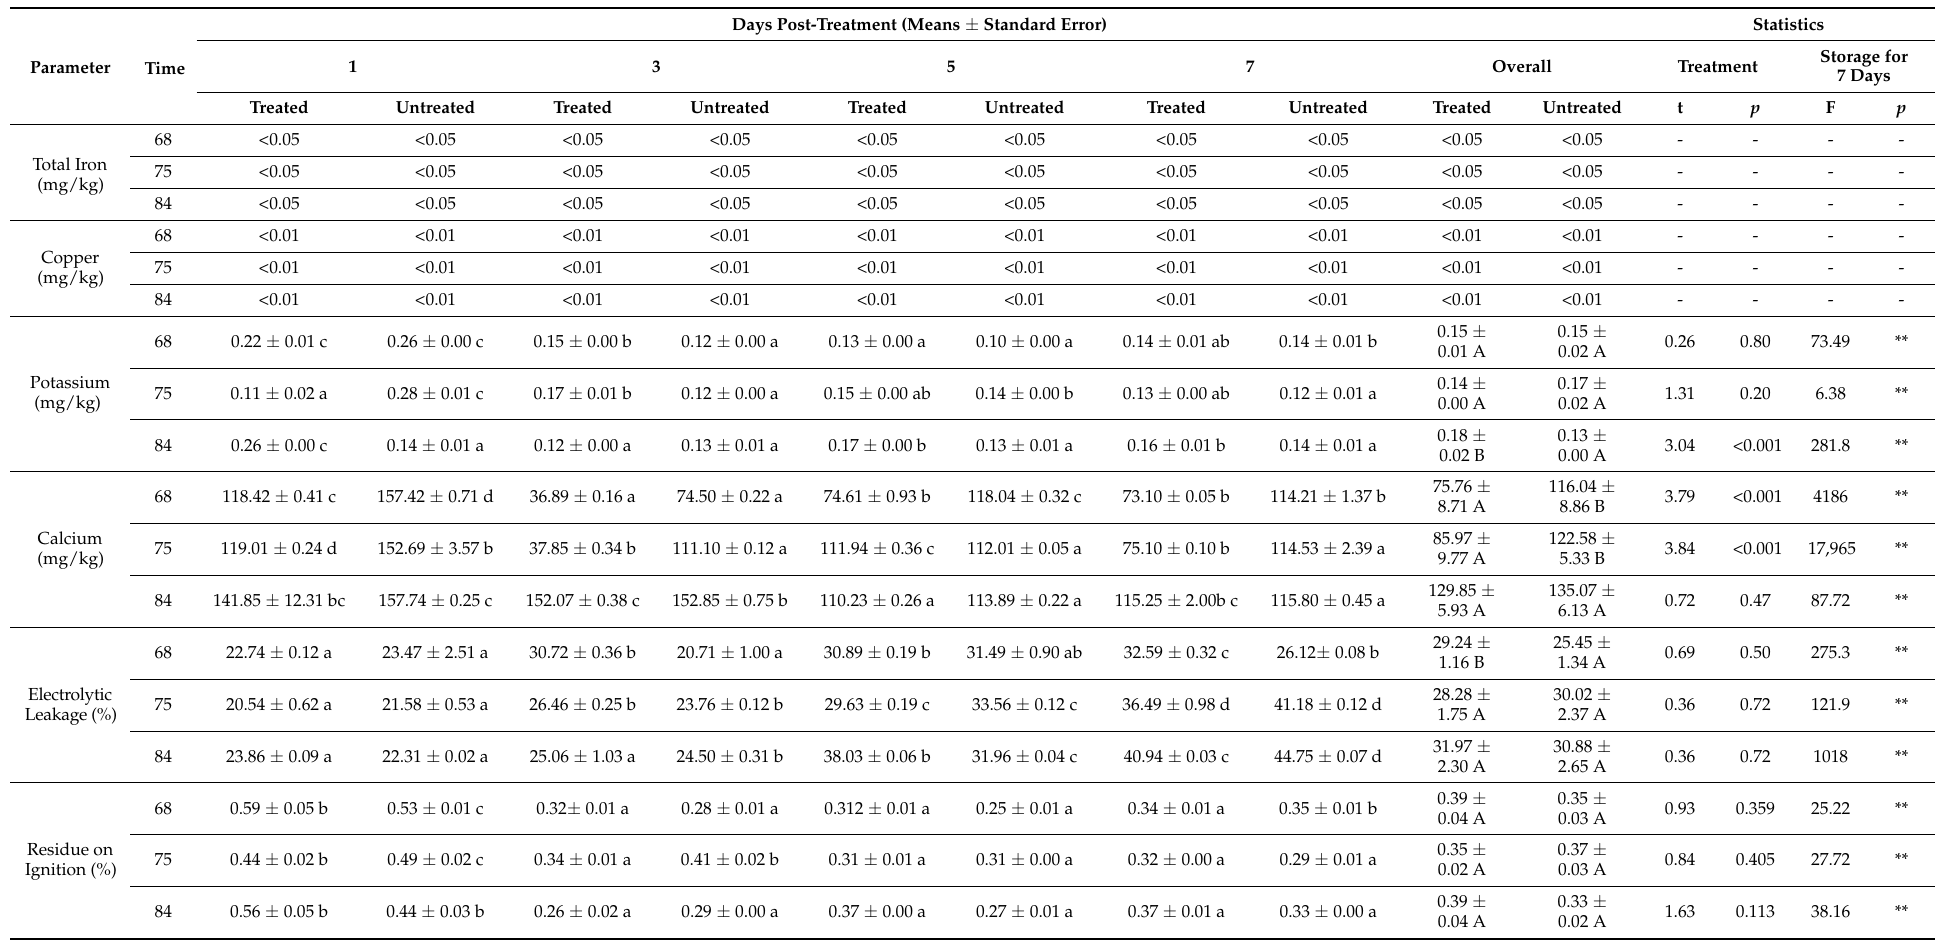
Table 4. Effect of hot water treatment at 46.1 ◦ C for different treatment durations on the minerals of Apple mango cultivar stored over 7 days